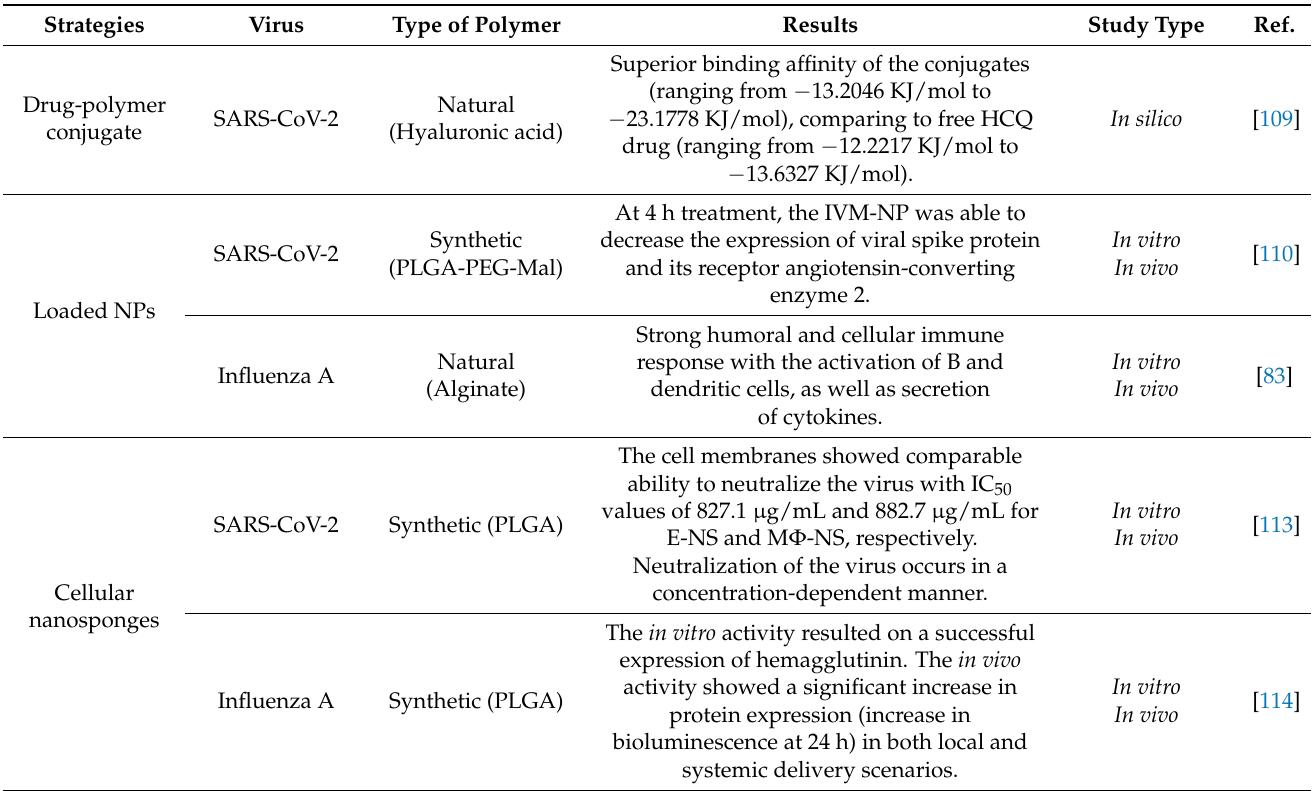
Table 3. Polymer-based strategies applied in the possible treatment of SARS-CoV-2 and influenza A